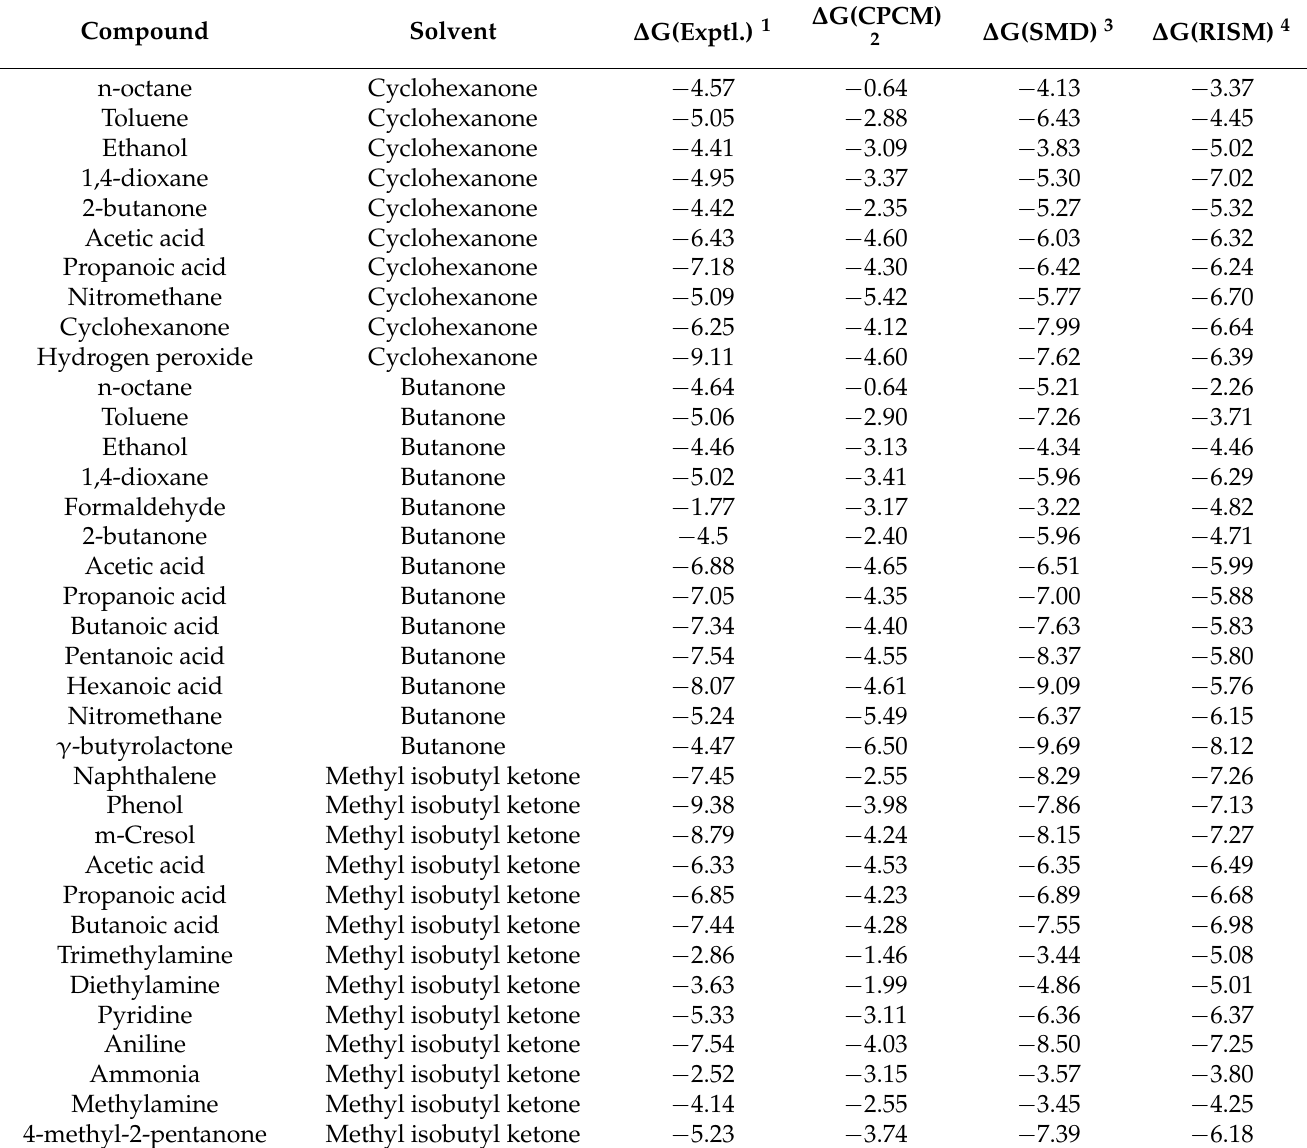
Table 4. Experimental and computed SFEs (in Kcal/mol) in various liquid